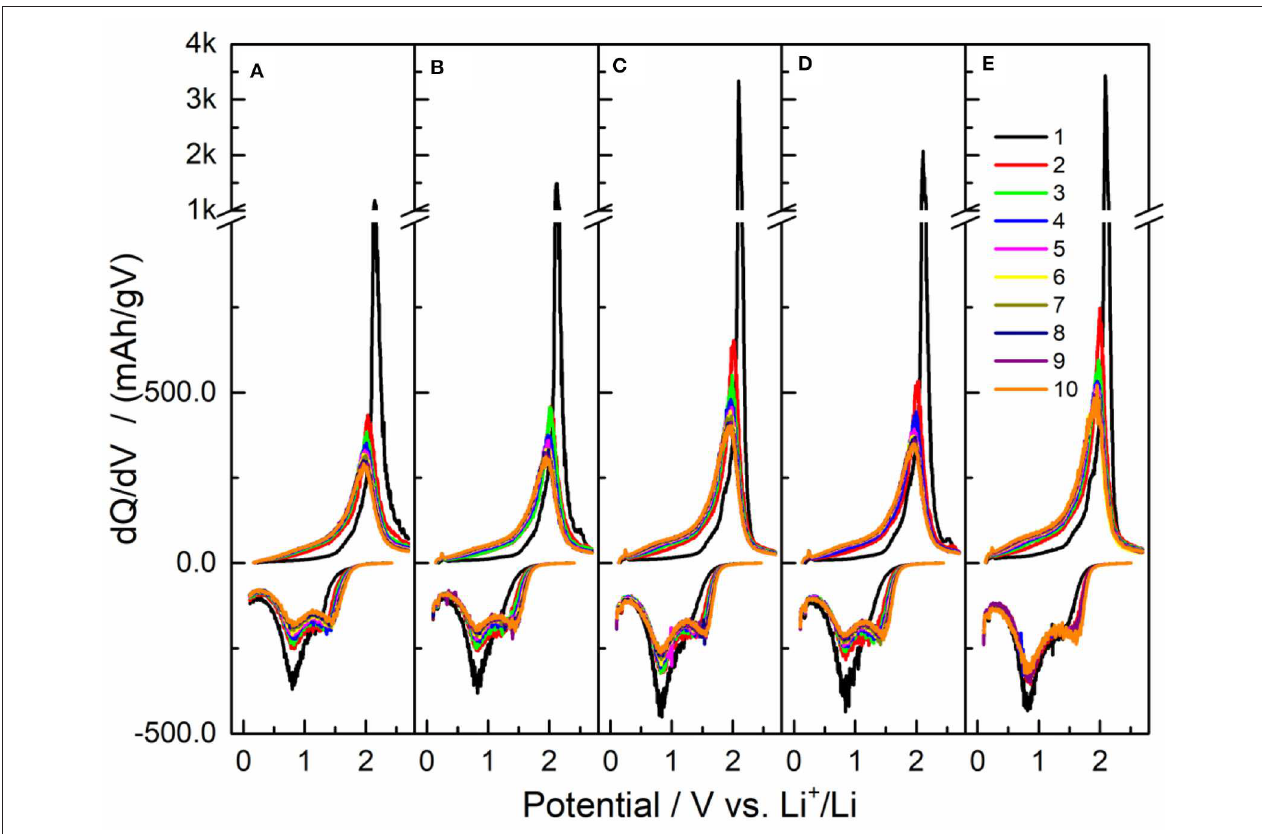
FIGURE 6 | The dQ/dV curves of the initial 10 charge-discharge cycles in Figure 5 for five samples, (A) I. Pristine LiBC, (B) II. 800-pellet, (C) III. 800-powder, (D) IV. 600-powder, and (E) V. 600-powder-Al.